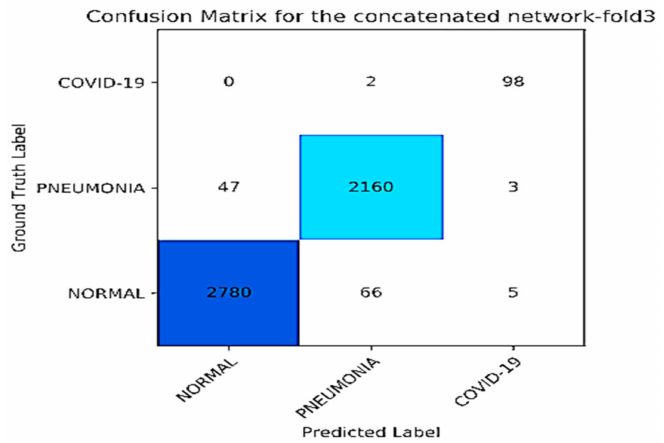
Figure 7. Confusion matrix of dataset 1.